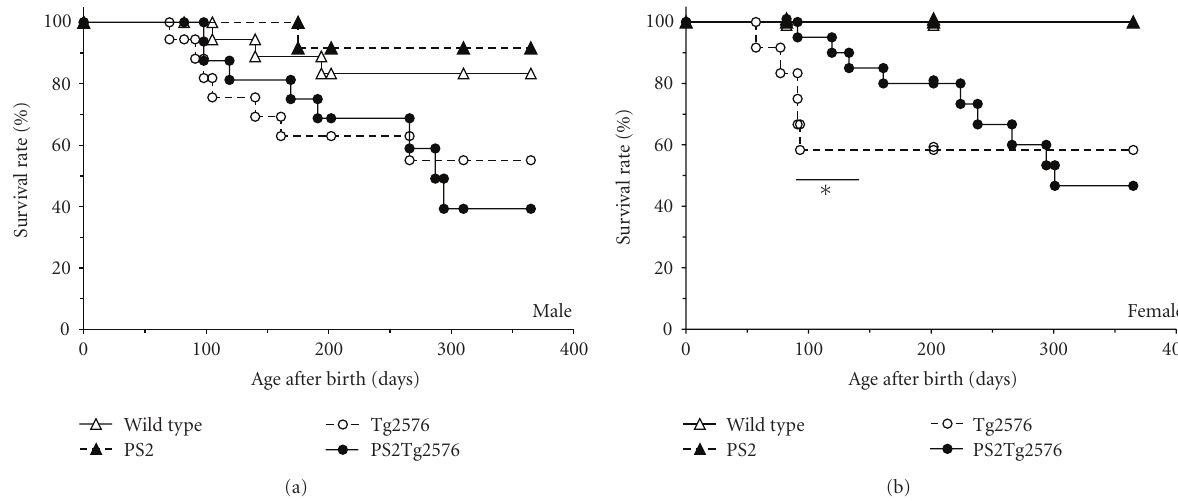
Figure 6: Kaplan-Meier survival curves of the PS2Tg2576 mice. (a) Survival plots for male mice (wild-type n = 20, PS2 n = 12, Tg2576 n = 18, PS2Tg2576 n = 18). (b) Survival plots for female mice (wild-type n = 16, PS2 n = 21, Tg2576 n = 12, PS2Tg2576 n = 21). Statistical significance was assessed using the original method of the log-rank test: ∗ P < . 05, PS2Tg2576 versus Tg2576 mice at the same age.